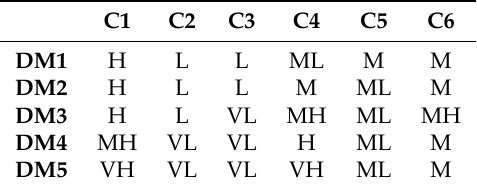
Table 5. DMs’ evaluation of criteria by using linguistic